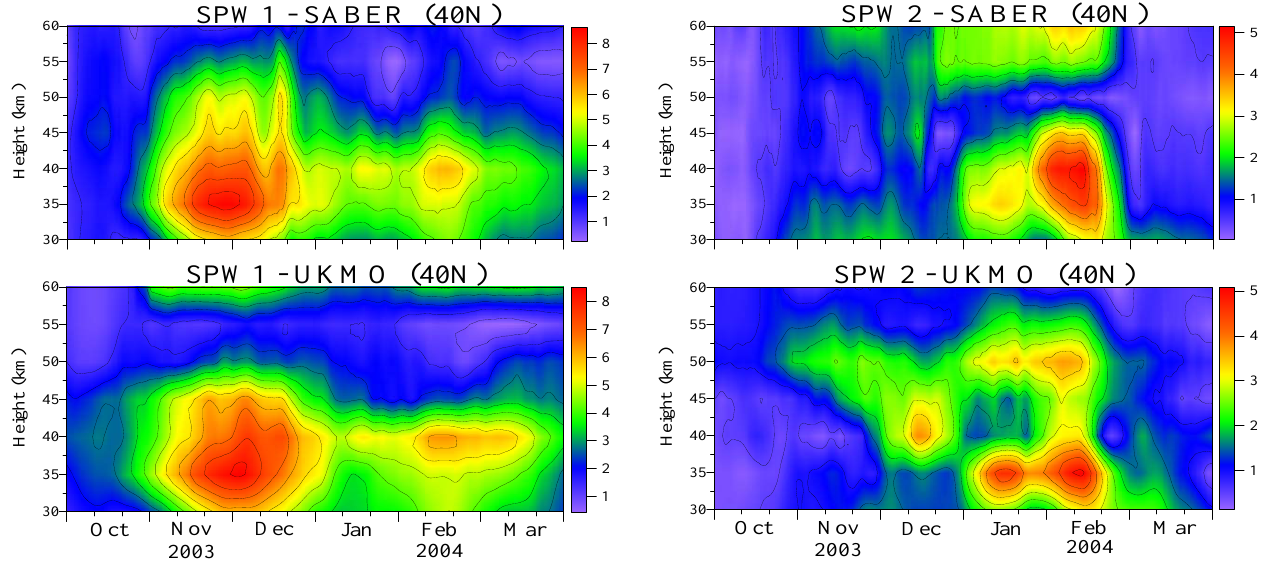
Figure 6 Fig. 6. Altitude-time cross sections of the SPW1 (left column of plots) and SPW2 (right column of plots) amplitudes seen in the SABER temperatures (upper row of plots) and UKMO assimilated temperature data (bottom row of plots) at 40 ◦ N and in the altitude range between 30 and